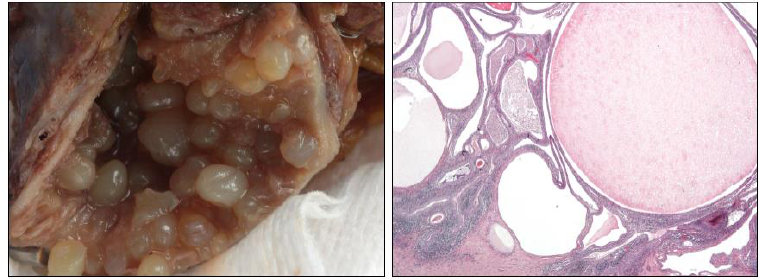
Figure 3. Gross and microscopic (20×) details in a florid case of ureteritis cystica.